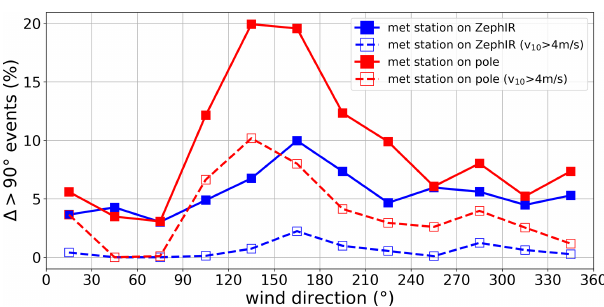
Figure 16. The (cid:49) > 90 ◦ occurrence for the lowest measuring height of 11m for different wind sectors (bin size 30 ◦ ), separating the data regarding the location of the meteorological station and including a wind speed threshold of 4ms − 1 (as measured at